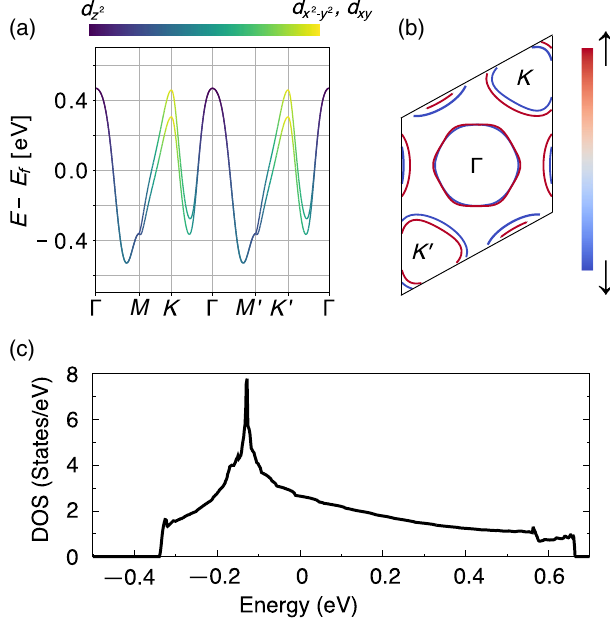
FIG. 2. (a) Band structure of monolayer NbSe 2 . The color along each band denotes the relative Nb d along the high-symmetry path, according to the color bar above the plot. (b) Cross section of the Fermi surface of monolayer NbSe 2 . Red denotes bands that have pure m blue denotes bands that have pure m of states of monolayer NbSe 2 . All of the calculations include SO